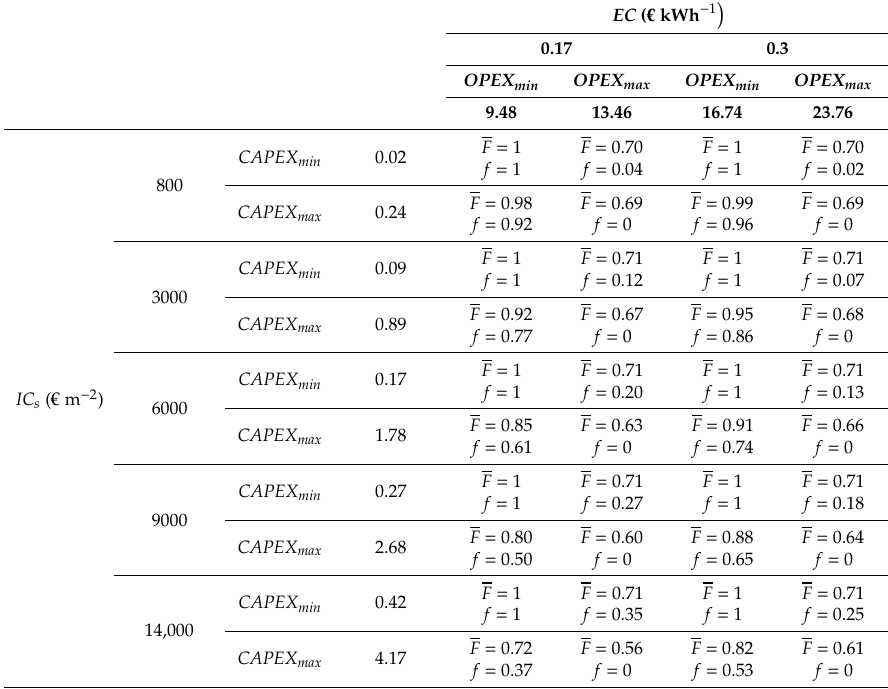
Table 6. CAPEX and OPEX minimum and maximum and their associated value of